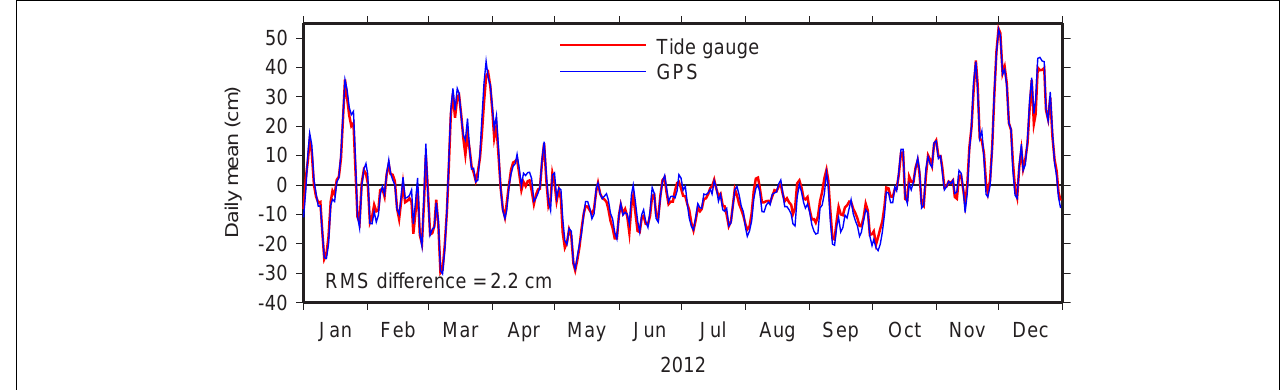
FIGURE 4 | Daily mean sea level during 2012 at Friday Harbor, Washington, United States, in the Strait of Juan de Fuca. Red line is daily means deduced from the Friday Harbor tide gauge, operated by NOAA; blue line is daily means determined by analysis of GPS reflected signals at station SC02, sited 300 m from the tide gauge. Adapted from Larson et al. (2017), who give further comparisons over a 10-year period, including comparisons of tidal